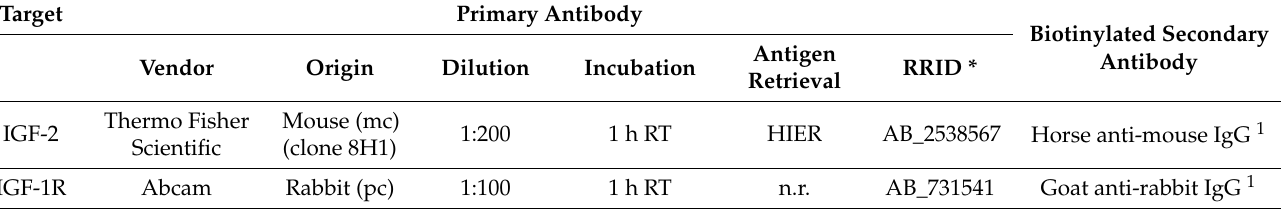
Table 3. Characteristics of the primary and secondary